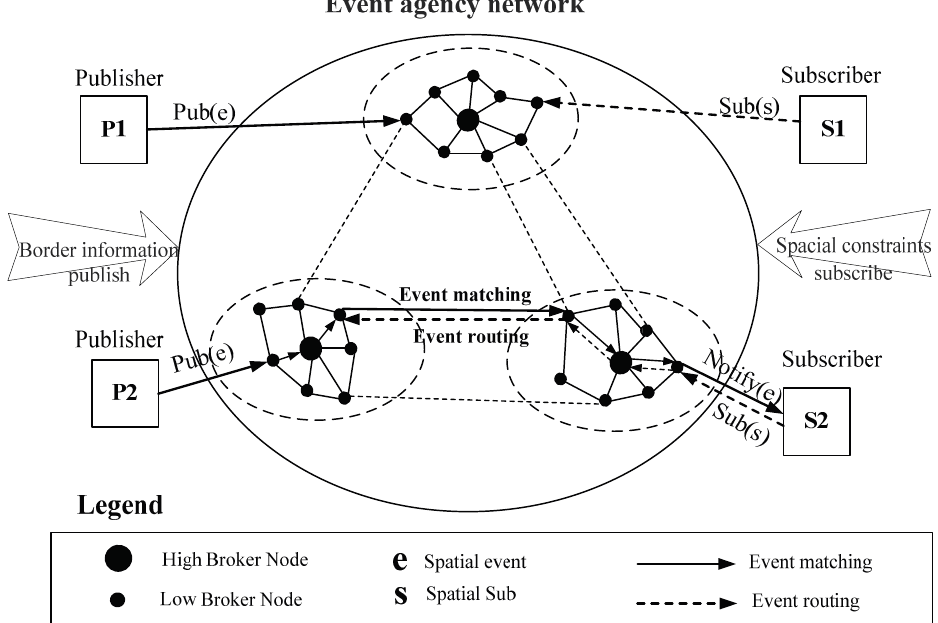
Figure 5. The event agency network of spatial